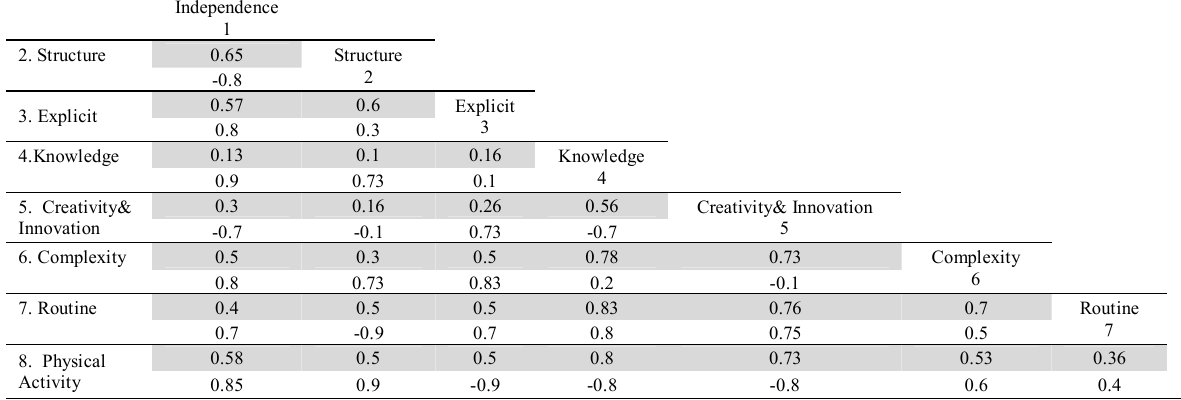
sv and I values that presented by SMEs i ij Independence